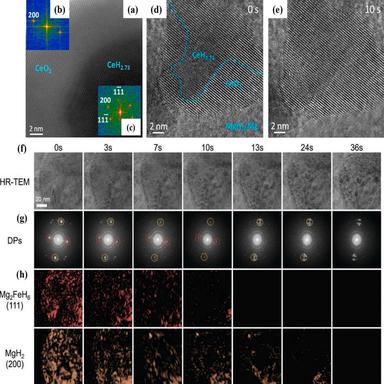
(a) HRTEM image of symbiotic CeH2.73/CeO2 nanoparticles of MgH2–Mg2NiH4–CeH2.73/CeO2 nanocomposites. Insets show the corresponding FFT images of (b) outer and (c) inner layers of the core-shell CeH2.73/CeO2 nanoparticles. (d, e) In-situ HRTEM images of CeH2.73/CeO2 nanoparticles during dehydrogenation: (d) initial state and (e) after 10 s. (f) In-situ HRTEM images of Mg2FeH6–MgH2 composite during dehydrogenation. Corresponding (g) diffraction patterns obtained through FFT and (h) inverse FFT images for Mg2F